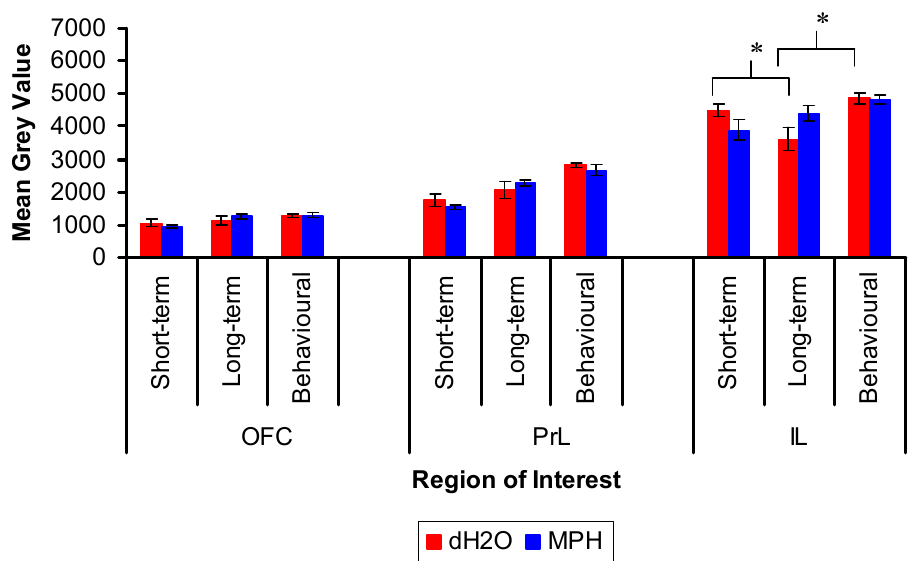
Figure 9. Mean (±SEM) tyrosine hydroxylase immunoreactivity in the lateral orbiotofrontal cortex (OFC), the prelimbic cortex (PrL), and infralimbic cortex (IL) of WKY rats, previously exposed to chronic methylphenidate (MPH, 2 × 2 mg/kg/day) or distilled water (dH O) treatment. Immunohistochemical staining was conducted in the short- and long-term 2 groups, 1 and 12 weeks after cessation of treatment, respectively, and following behavioural testing (12 weeks post treatment) in the behavioural group. Within each region of interest, there was a significant main effect of group such that the behavioural group had significantly more TH staining compared to the short-term and long-term groups, averaged across treatment. * Significant difference for the comparisons of interest for dH between the short- and long-term groups, and the long-term and behavioural groups, p <